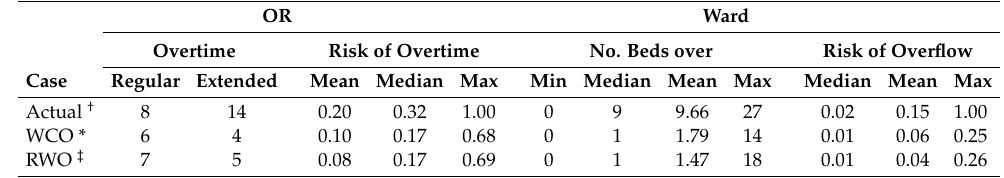
Table 1. Comparison between optimal solutions of the ward combinations optimization (WCO), the robust ward optimization (RWO) and actual schedule for the planning horizon. Regular and extended overtime show how often selected ORDS surpass the accepted risk for each group. Risk of overtime is the probability that the selected ORDS will surpass the block capacity. No. of beds over measures how many beds exceed the given number of staffed ward beds while risk of overflow is the likelihood of exceeding the number of staffed ward